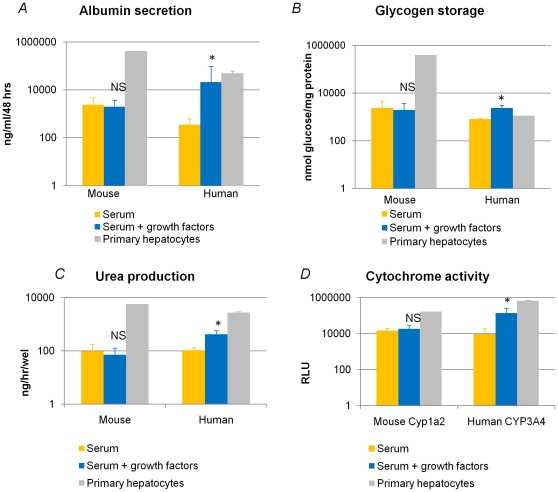
Functional characteristics of mESC and hESC progeny as well as primary hepatocytes at day 20 (n = 3, *p<0.05, NS = not significant).[A] Albumin secretion (ng/ml/48 hrs) [B] Storage of glycogen (nmol glucose/mg protein) [C] Urea production [D] Cytochrome P450 activity. In mESC progeny no significant differences were observed between the two conditions, while in the hESC progeny functional capacities were significantly higher in the presence of additional growth factors.